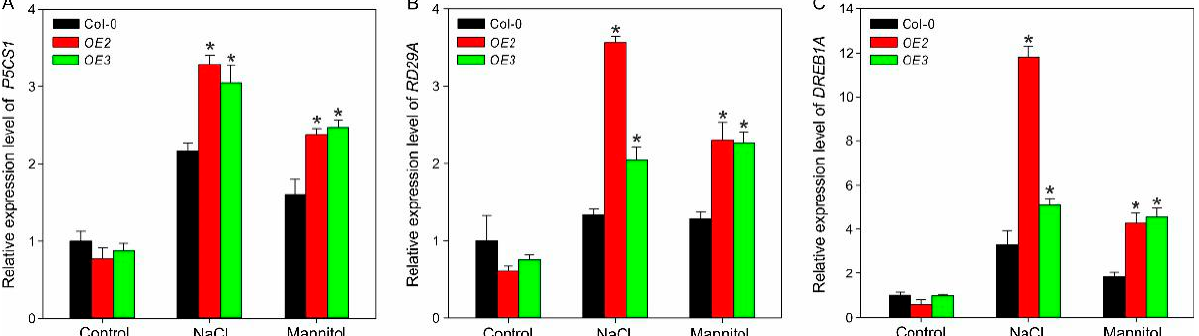
Figure 7. Relative expression levels of stress-related genes in wild-type and transgenic plants. The expression levels of P5CS1 ( A ), RD29A ( B ), and DREB1A ( C ) were tested in 7-day-old wild-type (Col-0) and transgenic plants ( OE2 , OE3 ) under normal (Control), salt (NaCl), and osmotic (Mannitol) treatments. Asterisks indicate significant differences from Col-0. Data shown are means of three independent biological replicates. * p < 0.05, one way ANOVA.